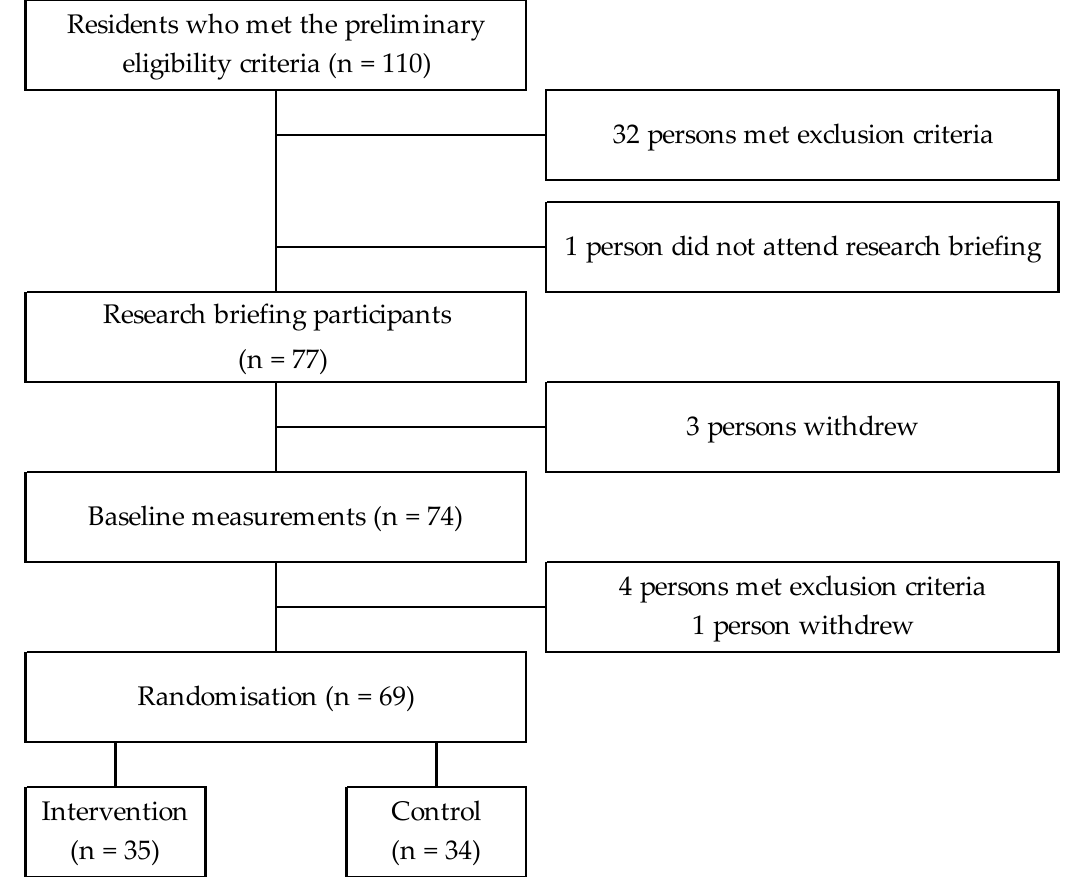
Figure 1. Recruitment flowchart of study participants.